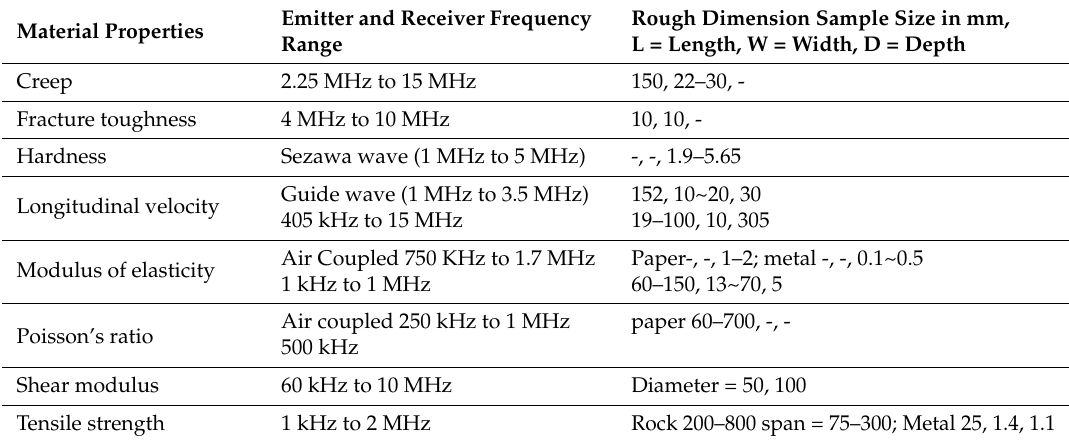
Table 2. Frequencies used for determining properties of solid materials associated with the dimensions of the test samples.